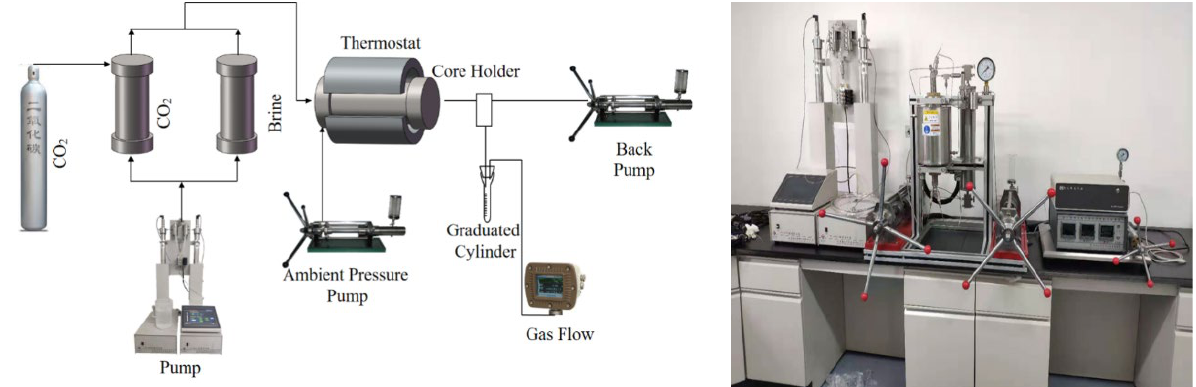
Figure 6. Schematic diagram and picture of the dynamic displacement experimental set-up. The reaction temperature of the dynamic experiment is 100 ◦ C, and the injection pressure remains constant at14 MPa, which is consistent with the static experiment. The confining pressure is 17